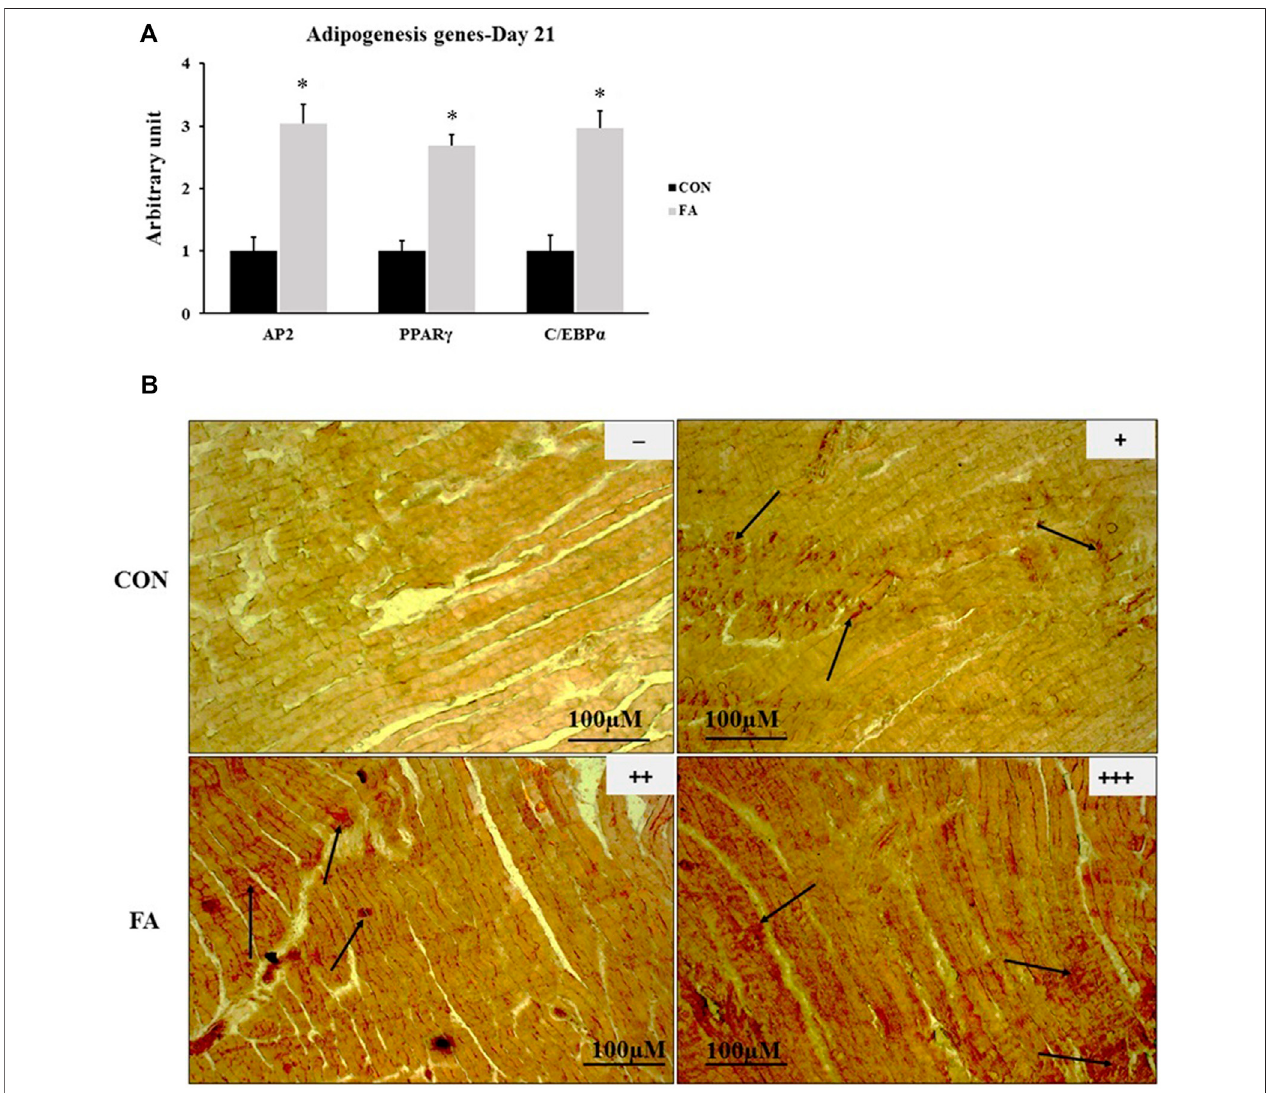
FIGURE 9 | Effect of maternal EPA/DHA on ectopic lipid accumulation in muscles of day 21 weaned mice. The mothers were fed either control diet (CON) or EPA/ DHA enriched diet (FA) during the entire period of pregnancy and lactation. (A) The relative expression of adipogenesis regulating genes. The raw Ct was normalized to thevalueof18 s.Alldatarepresentasmean±SEM. p < 0.05byStudent ’ st-test( n =6). (B) ArepresentativemicroscopicimageofmusclesamplesstainedwithOilredO inday21offspringfedcontroldietorEPA/DHAenriched diet.Themagni fi cationis×10andscalebaris100 μ m.Blackarrowsrefertoaccumulatedfat.( − )indicates absence the accumulation of fat neither in the sarcoplasm of the fi bers nor in endomysium (between fi bers). (+) represents mild fat in fi ltration. (++) indicates a moderate load. (+++) indicates an overload of fat.